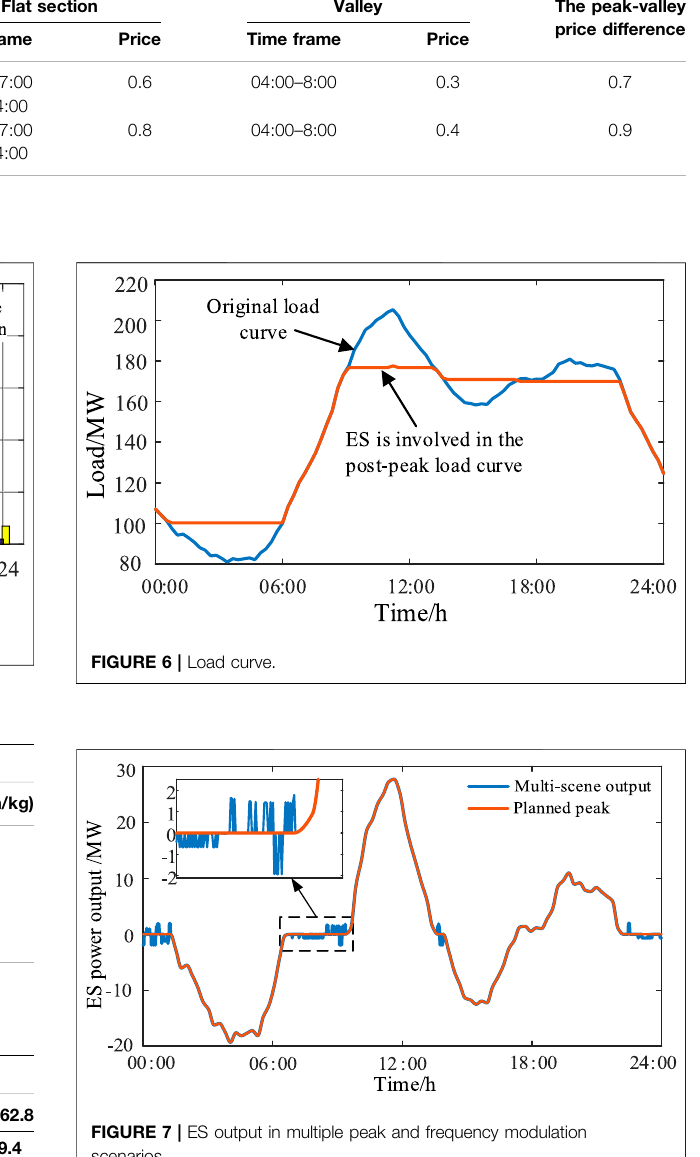
FIGURE 7 | ES output in multiple peak and frequency modulation scenarios.